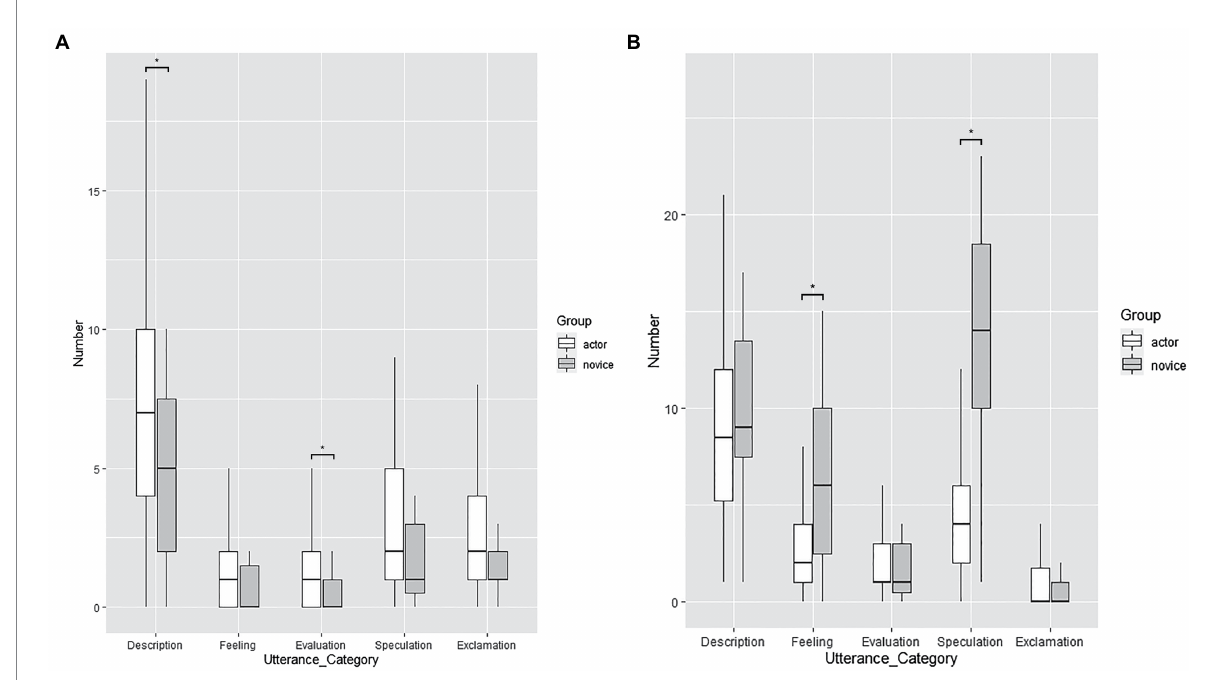
FIGURE 2 Difference between professional and novice actors in each kind of utterance per session (* p < 0.05), respectively for executors (A) and observers (B)